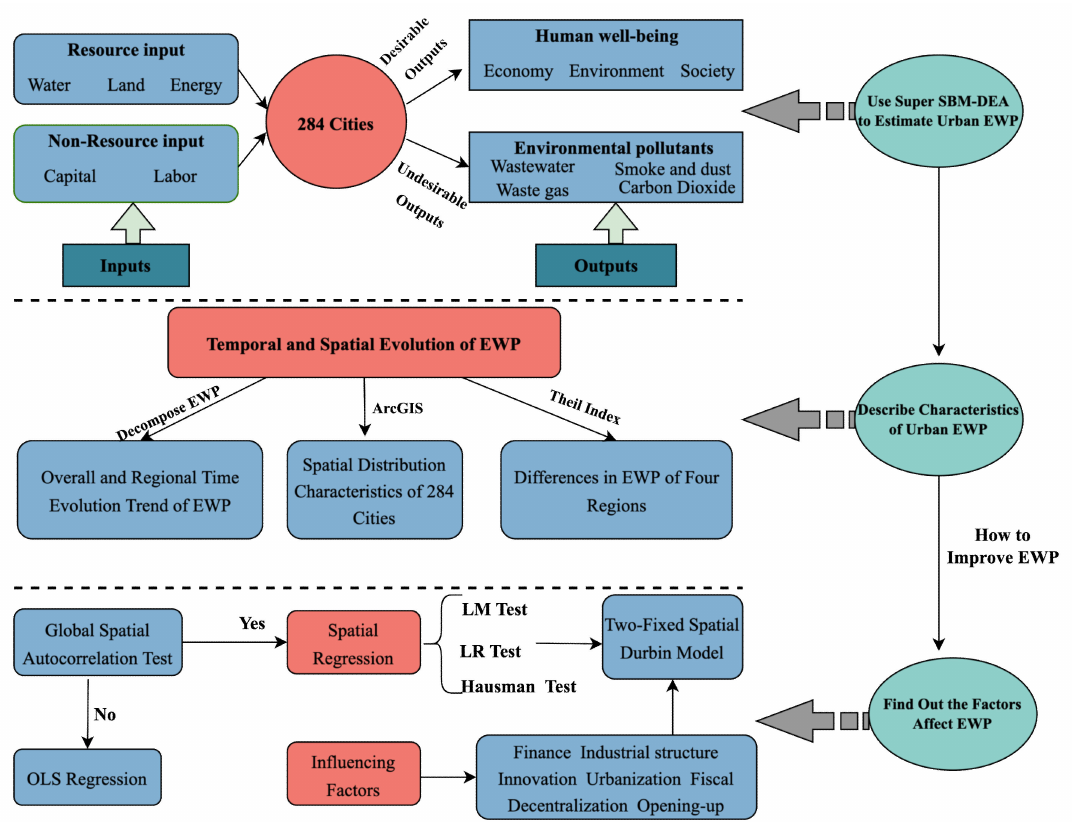
Figure 2. Research flow